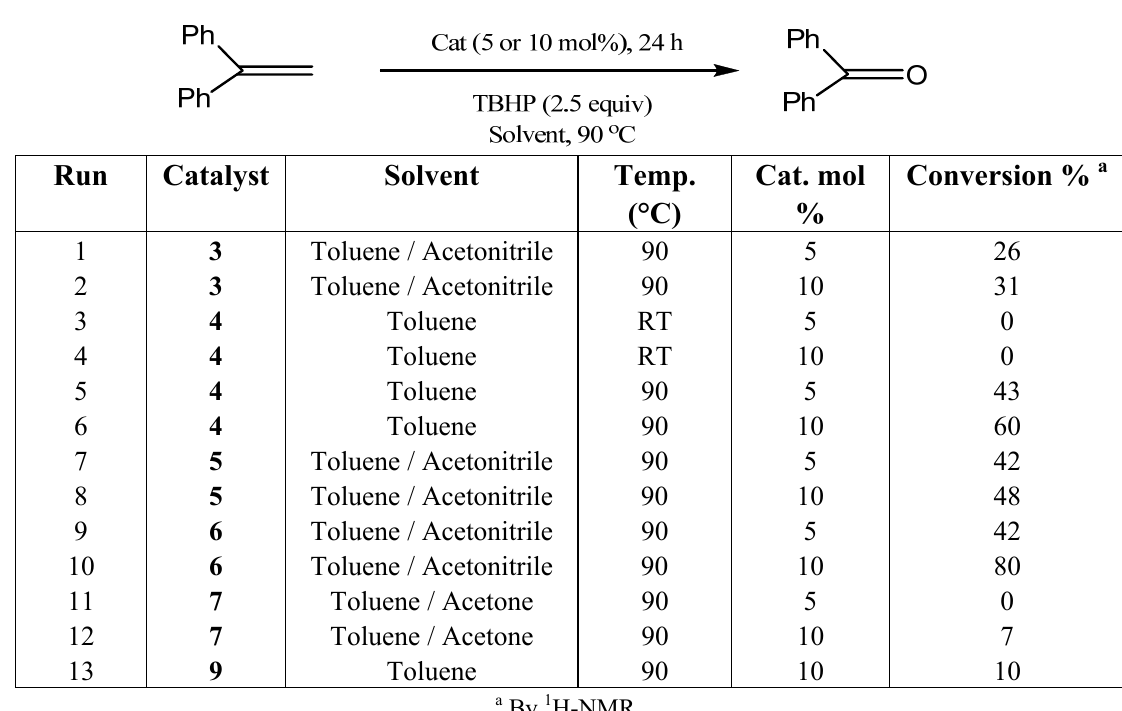
Table 2. Oxidative Cleavage of Diphenyl